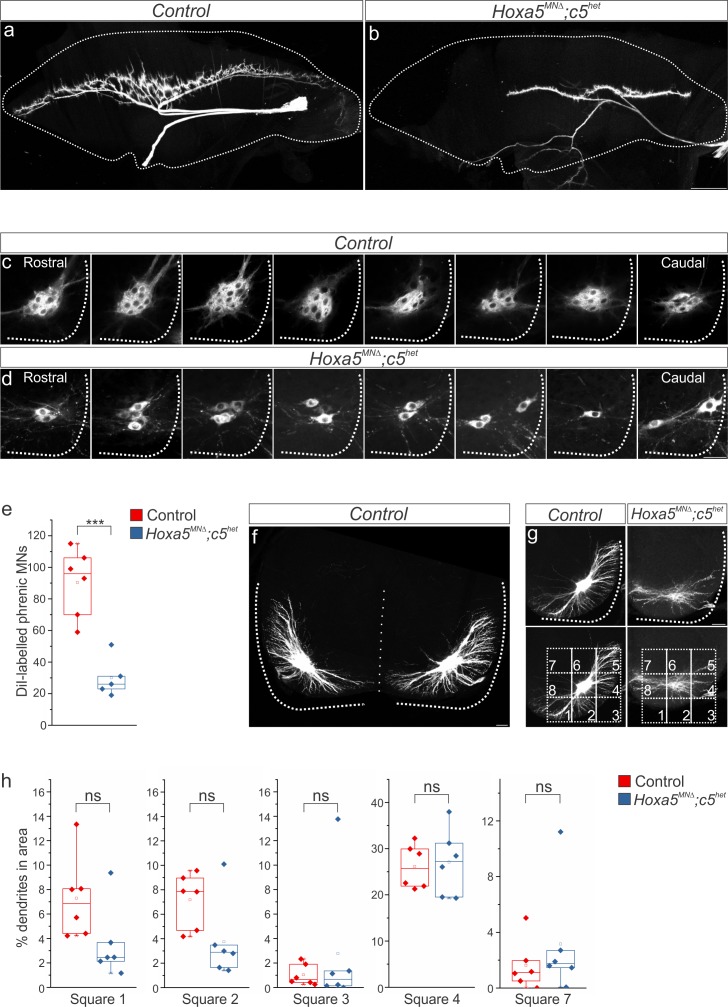
Hox5 genes dictate phrenic MN organization.(a-d) diI injections into the phrenic nerve label both phrenic projections at the diaphragm (a–b) and cell bodies in the cervical spinal cord (c–d). (c–d) Retrogradely-labeled phrenic MNs in Hoxa5MNΔ; c5het mice appear disorganized and lose their clustering at e18.5. Although there is significant phrenic MN loss, it is distributed equally along rostrocaudal levels of the spinal cord. All labeled phrenic MNs from a single control (c) and Hoxa5MNΔ; c5het (d) embryo are shown in a rostral to caudal direction. (e) Quantification of diI-labeled phrenic MNs. (f) Phrenic dendrites rarely cross the midline in control animals. (g) A numbered grid was superimposed on PMC neurons to measure changes in dendritic orientation (see also Materials and methods). (h) Quantification of dendritic orientation. There are no significant changes in the percentage of dendrites projecting in the ventral (squares 1–3), lateral (square 4) or dorsomedial (square 7) directions. Scale bar = 500 μm in b, 50 μm in d, f, 100 μm in g.